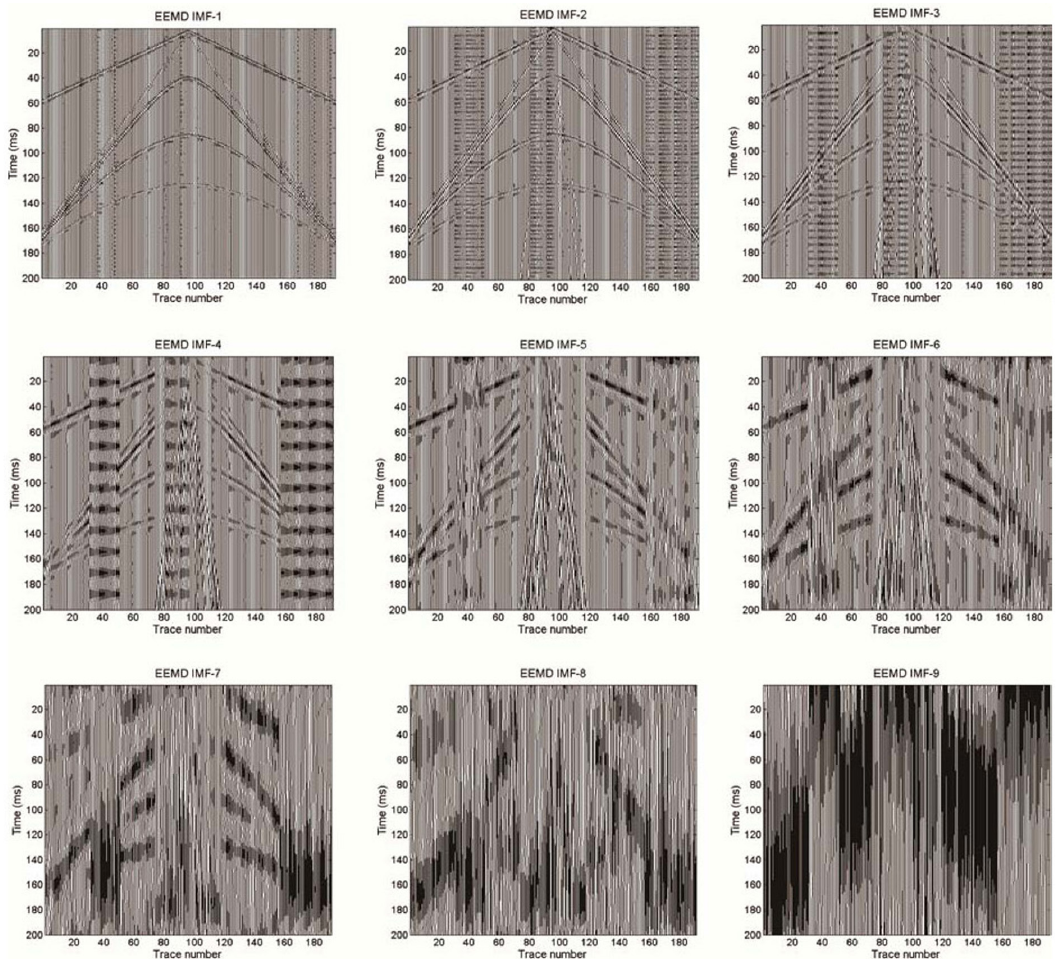
Fig. 3. Filter bank of the harmonic noise affected model data before logarithmic